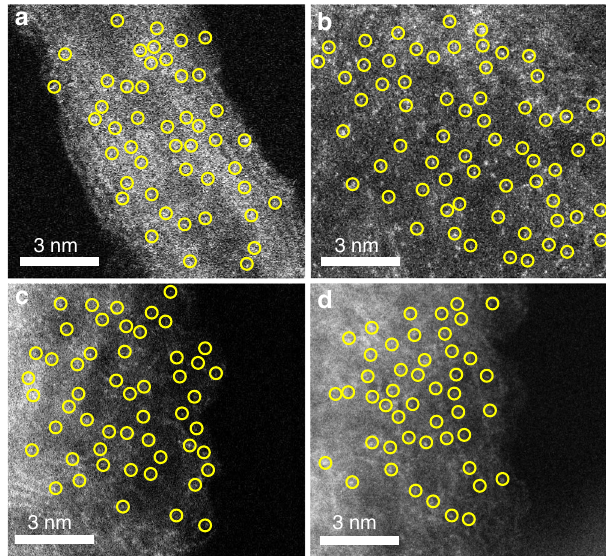
Fig. 4 Atomic structural characterizations AC HAADF-STEM images of a Cu ISAS/N-CNTs, b Cu ISAS/N-rGO, c Mo ISAS/NC, and d Sn ISAS/NC